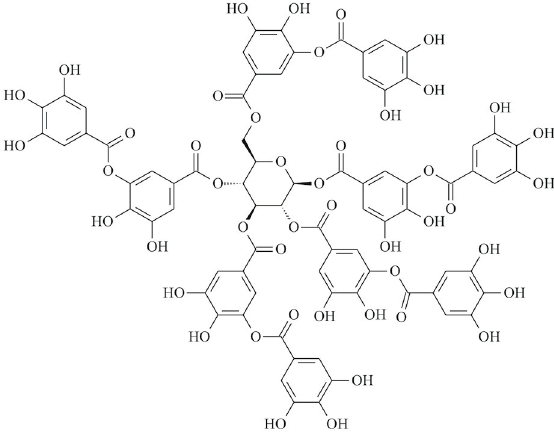
Figure 1 - Chemical structure of TA